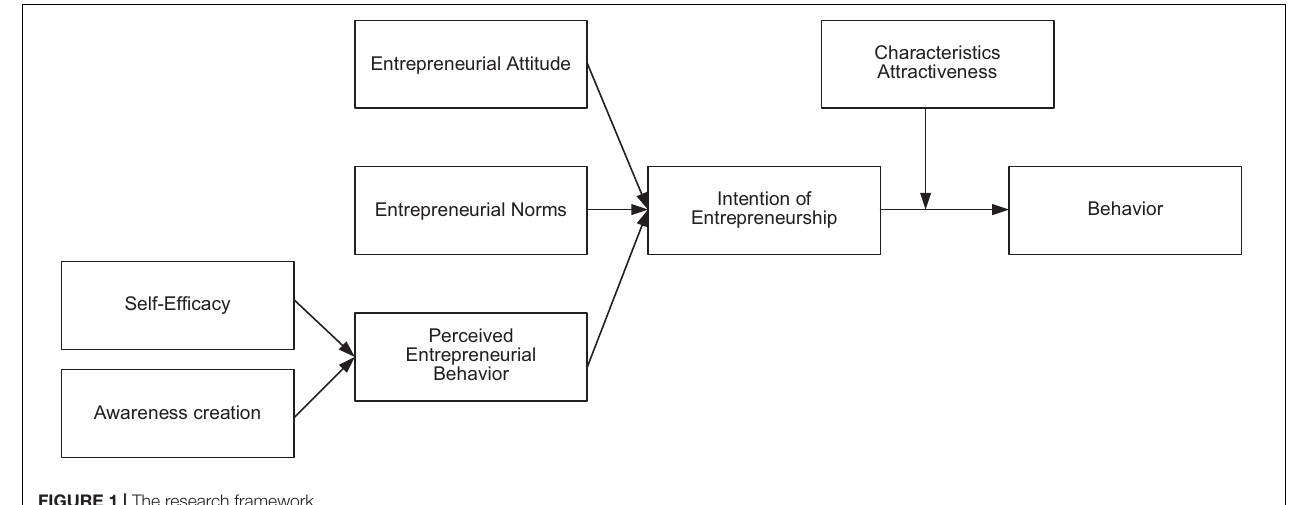
FIGURE 1 | The research framework.